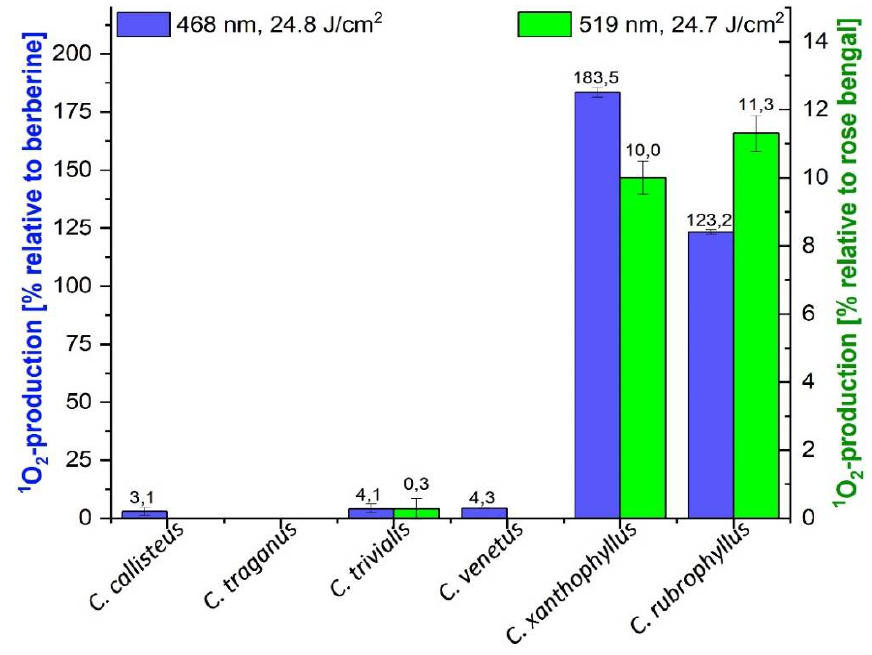
Figure 2. Relative singlet oxygen production of the six investigated fungal extracts calculated by irradiating the samples in ethanol with blue light ( λ = 468 ± 27 nm, 1.24 J cm − 2 min − 1 , berberine = positive control) and green light ( λ = 519 ± 33 nm, 1.34 J cm − 2 min − 1 , rose bengal = positive control). The relative yields are given with standard error.